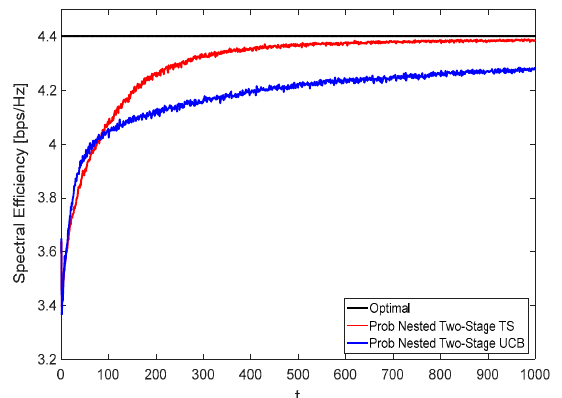
Figure 9. Spectral efficiency convergence at 50% blockage using K = N = M = 16.